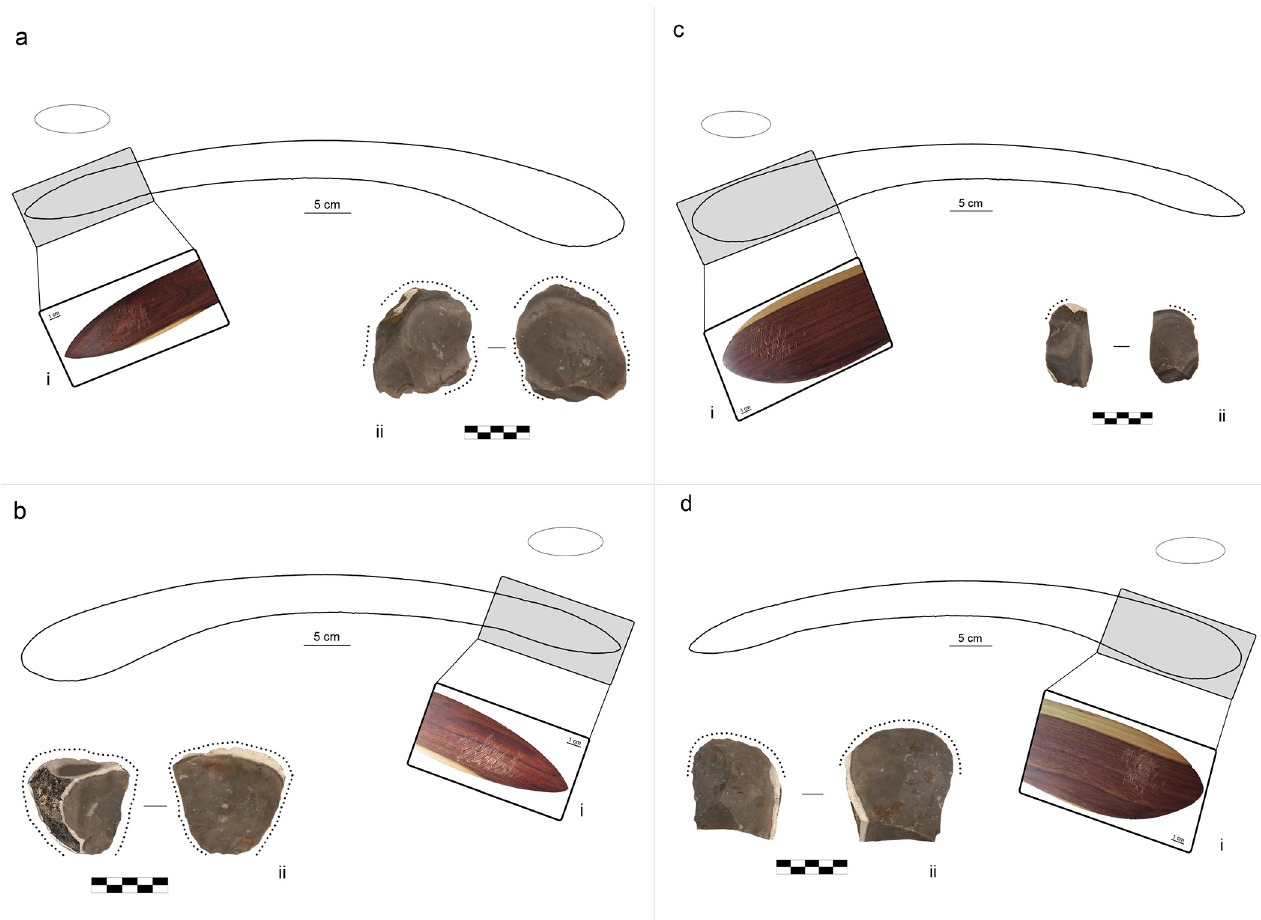
Fig 5. Results of retouching session 2 on the boomerang B4 (bi-convex cross-section and location of use areas). (a) location of use area B4_1 (i) use area B4_1 (1x), (ii) retouched flake F60; (b) location of use area B4_2(i) use area B4_2 (1x), (ii) retouched flake F35. (c) location of use area B4_3, (i) use area B4_3 (1x), (ii) retouched flake F81; (d) location of use area B4_4(i) use area B4_4 (1x), (ii) retouched flake F41.